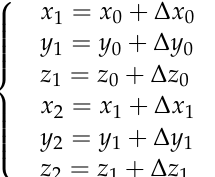
Figure 2. Single-satellite dynamic positioning process based on the inertial navigation system (INS).